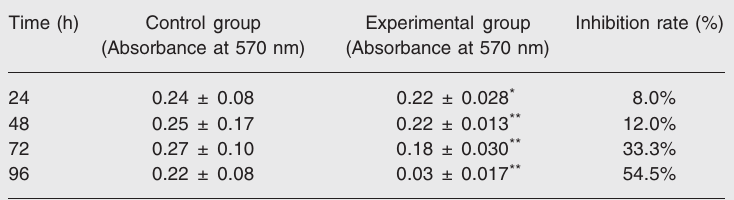
Table 1. Time-dependent effect of 40 µg/mL of the fraction FA-2-b-ß extract on the proliferation of HL-60 cells.